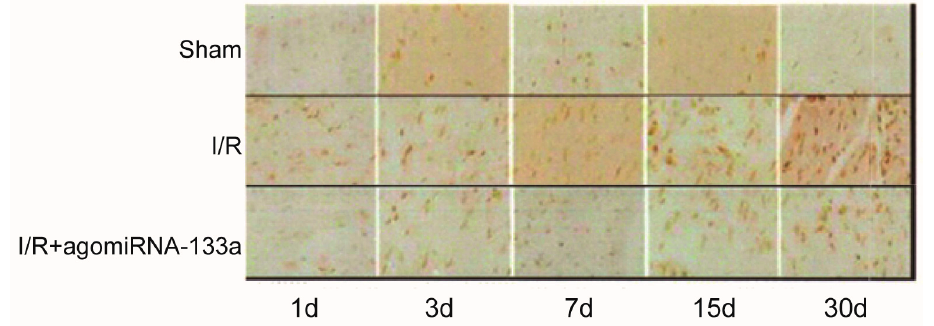
Figure 3. Detection of the apoptosis rate of myocardial cells by TUNEL